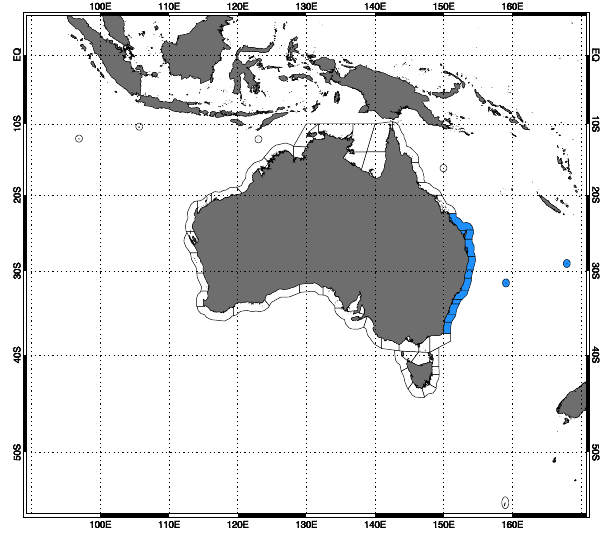
Fig. 3. Desired warning scheme for the Chile 1960 event. Coastal zones assigned a marine threat are shaded in